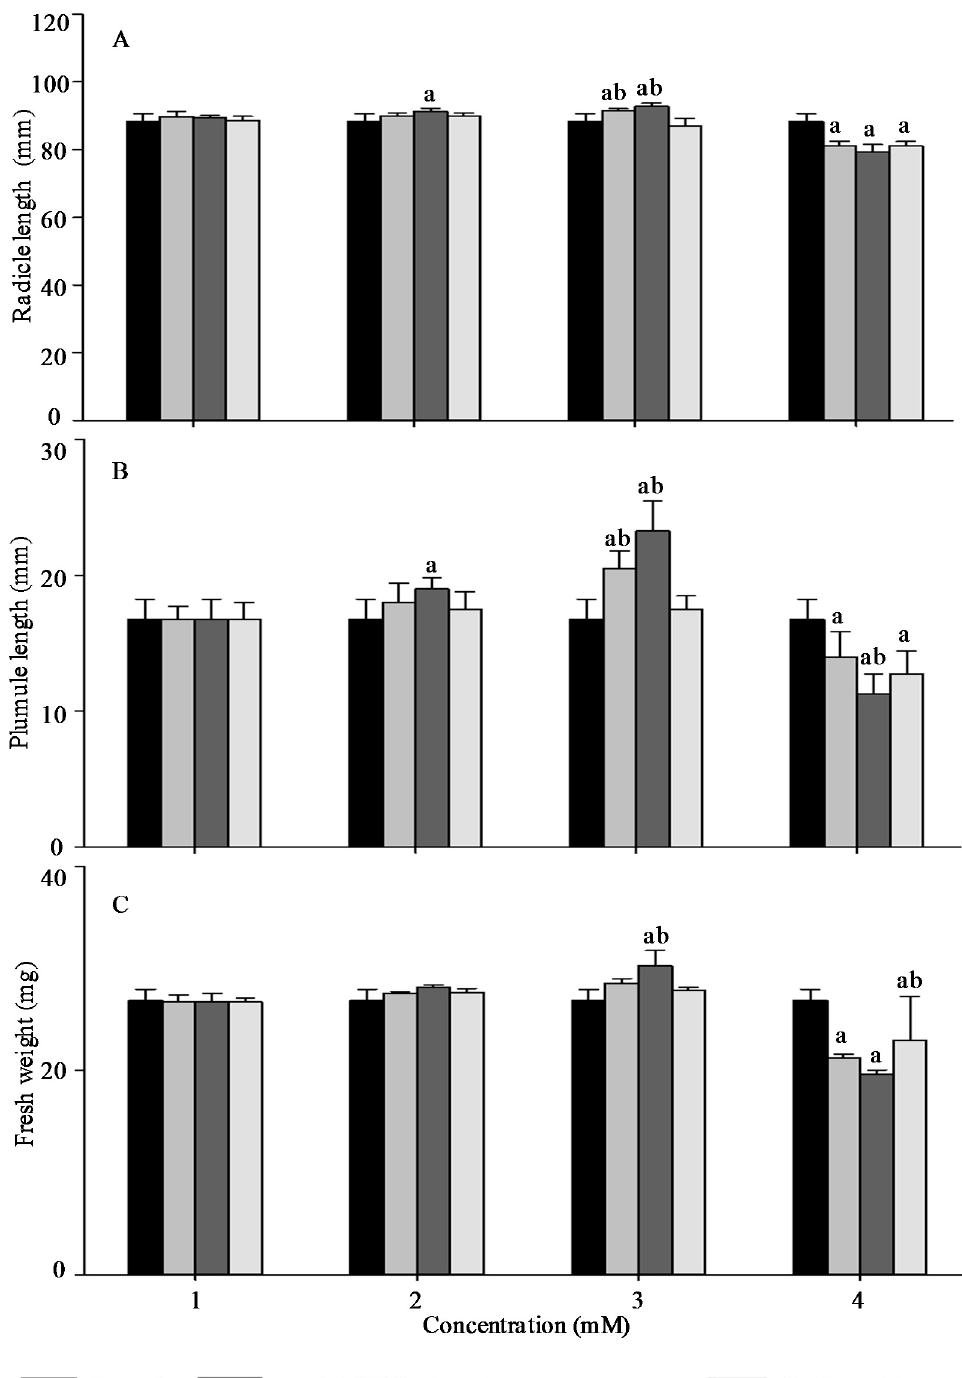
Figure 3. Effect of rac-4,8-DHT, S -(+)-isosclerone, and R -( − )-regiolone at different concentrations on radicle length ( A ); plumule length ( B ); and fresh weight ( C ) in cucumber. a denotes a significant difference between control and treatments ( p < 0.05); b denotes a significant difference among rac-4,8-DHT, S -(+)-isosclerone, and R -( − )-regiolone ( p < 0.05).